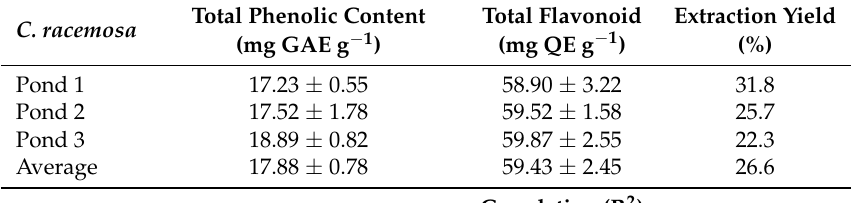
Table 6. Antioxidative properties of C. racemosa and its correlation with phenolics and flavonoids content. C.